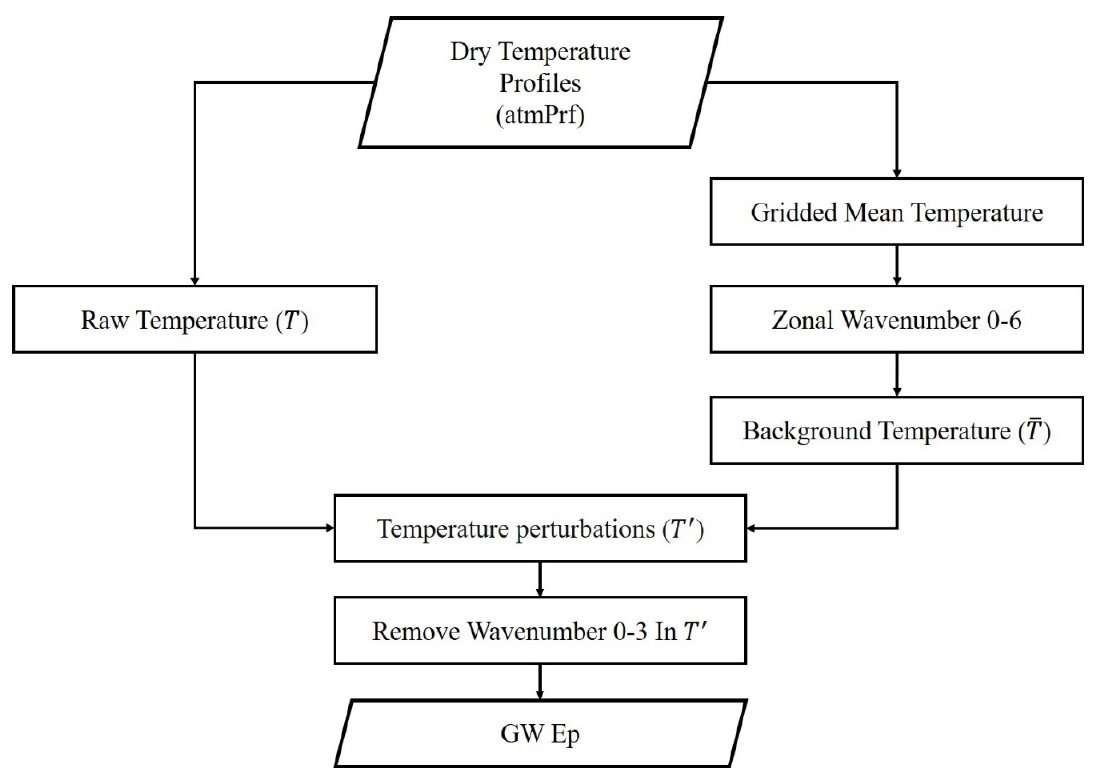
Figure 1. Flow chart for calculating GW Ep.